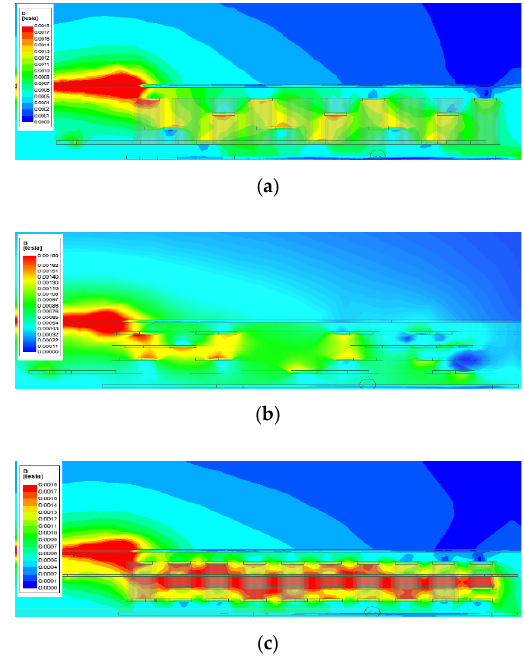
Figure 7. Finite element analysis of spiral pattern coil: ( a ) sawtooth pattern; ( b ) triangle pattern; and ( c ) fishbone pattern.